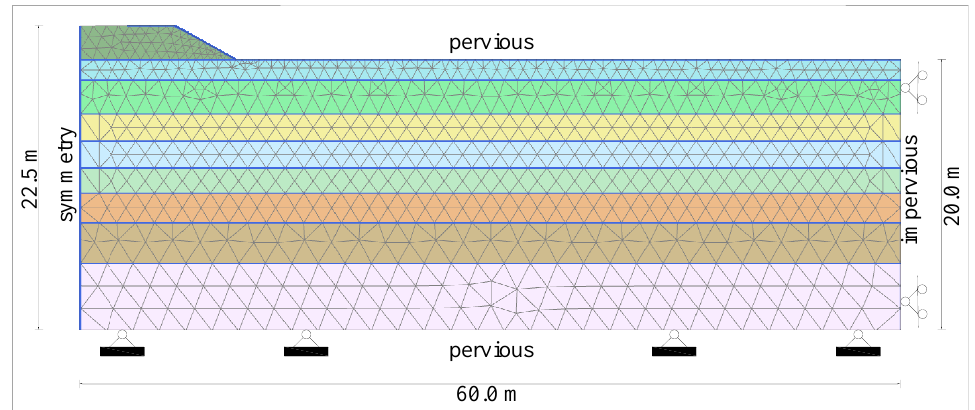
Figure 4. Cross section of the embankment and key instrumentation points of Embankment B. (adapted from [8]).